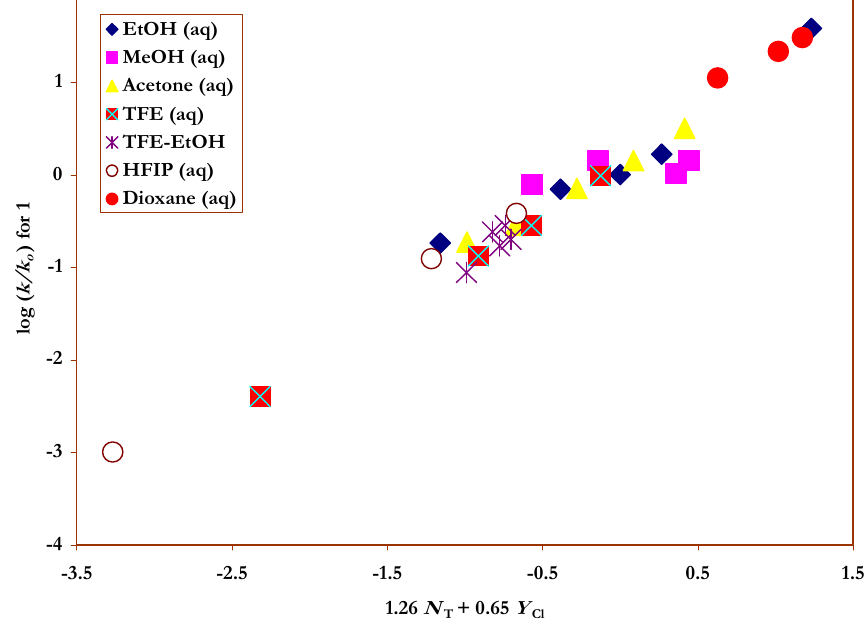
) vs. (1.26 N + 0.65 Y ) for the solvolyses of benzene- o T Cl